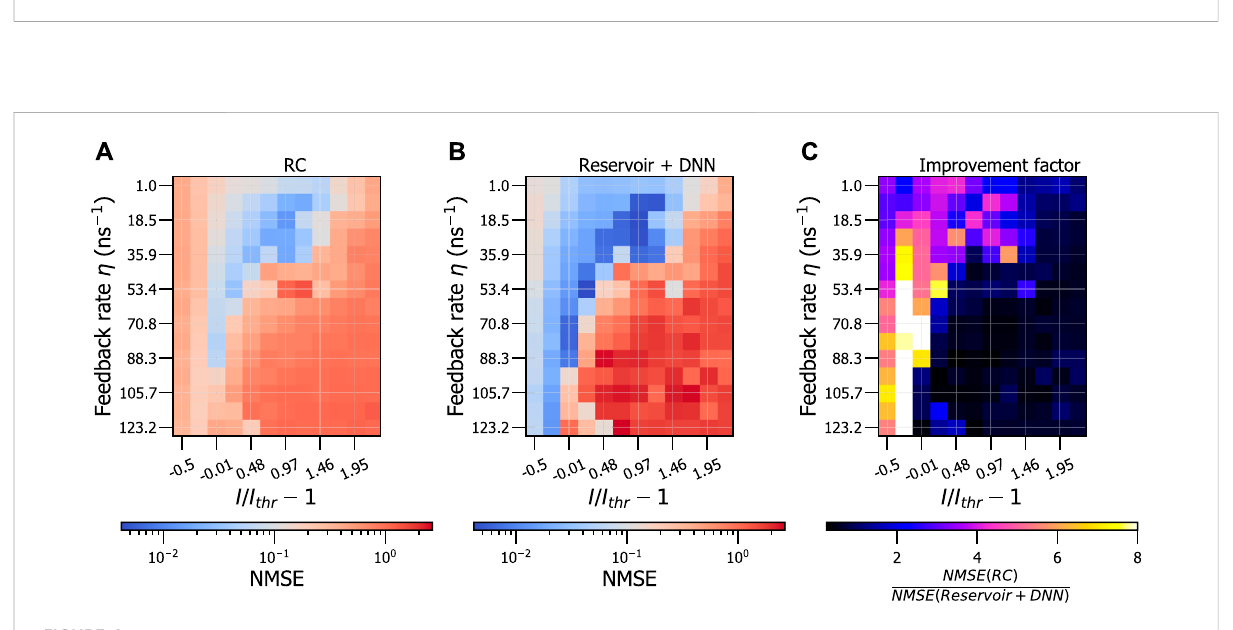
compared to the RC system (C)